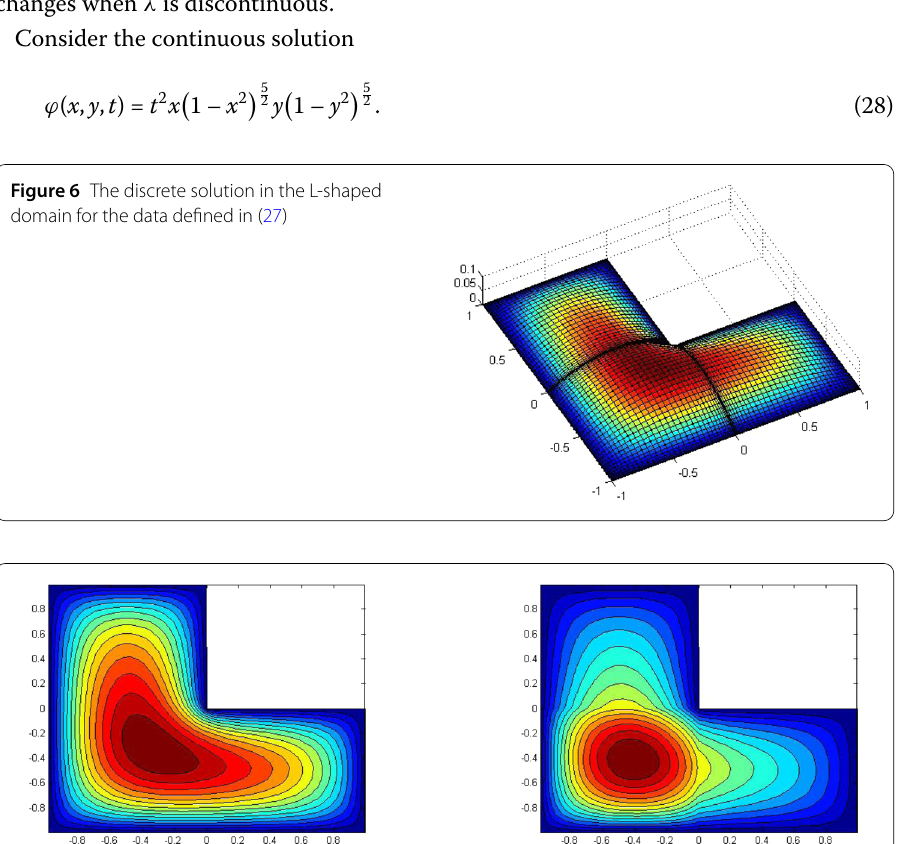
Figure 6 The discrete solution in the L-shaped domain for the data defined in (27)